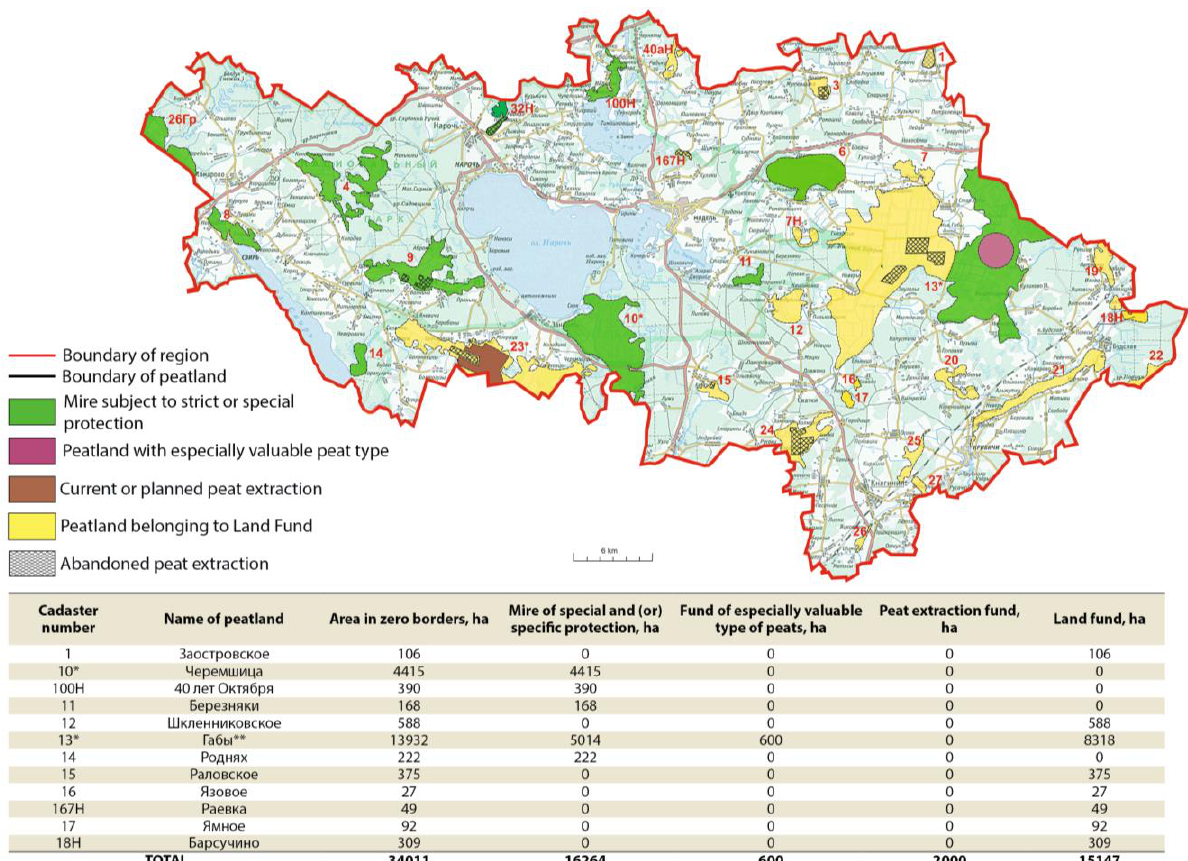
Figure 9. Map showing the distribution of peatlands allocated to each type of use in Myadel district of Minsk